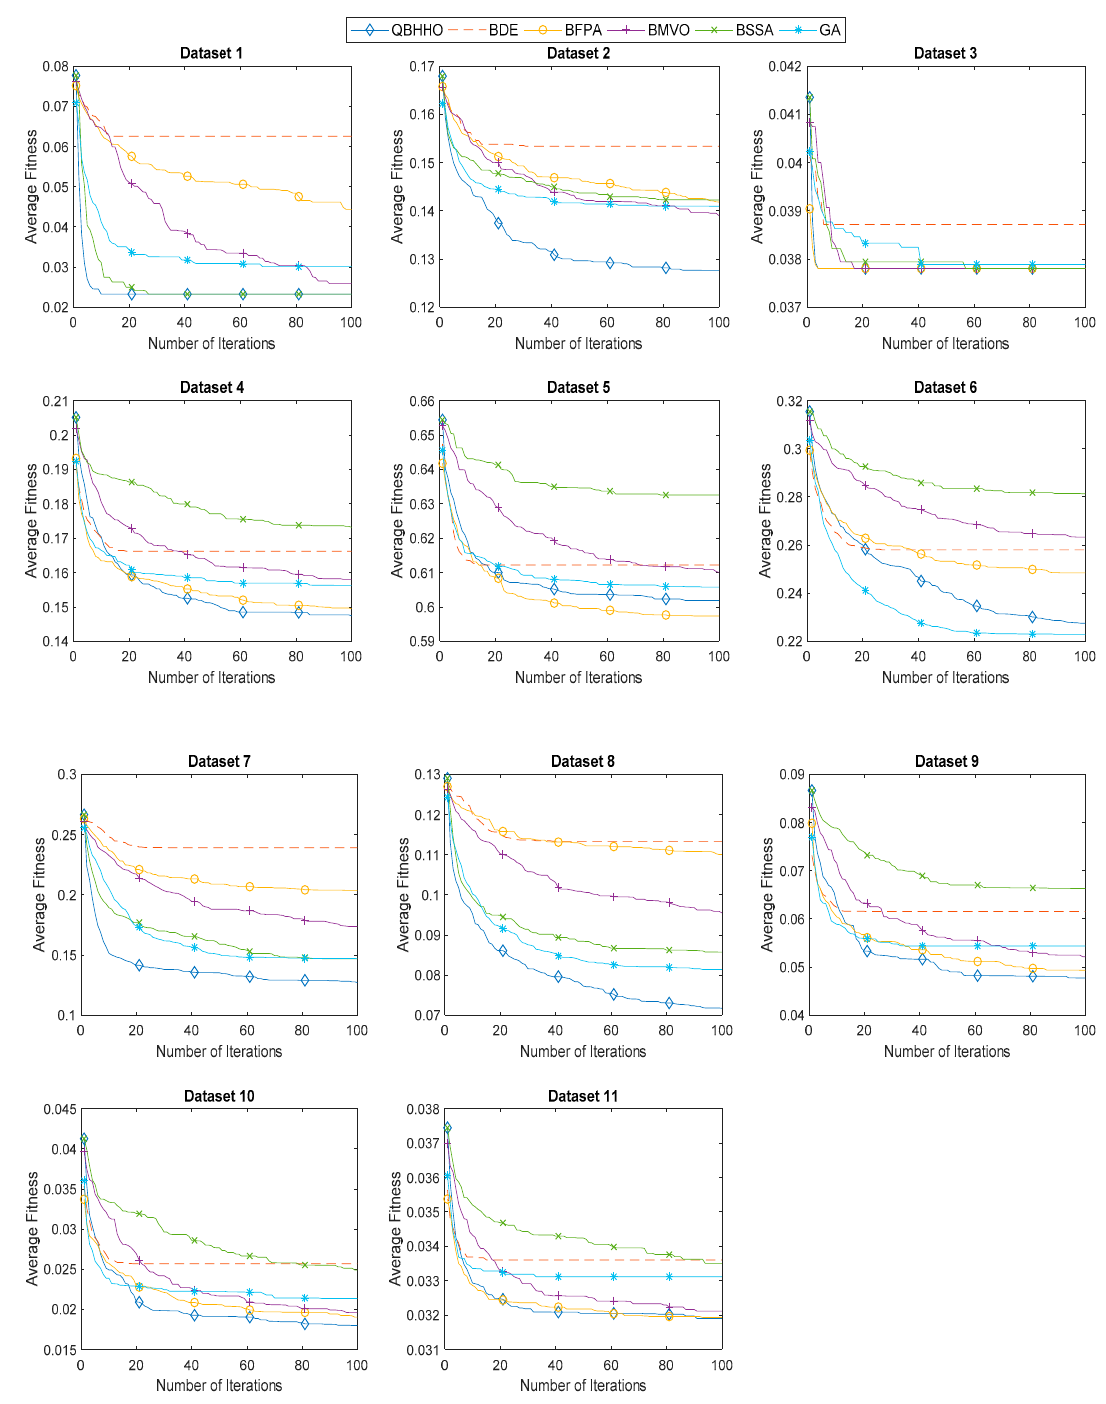
Figure 7. Convergence curves of six di ff erent algorithms on datasets 1–11.